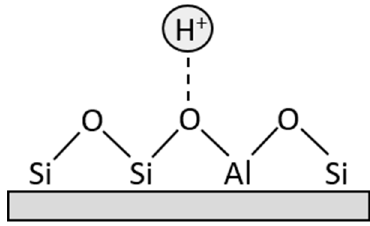
Figure 6. Illustration of Bronsted acid sites in Ni/Al-HMS.